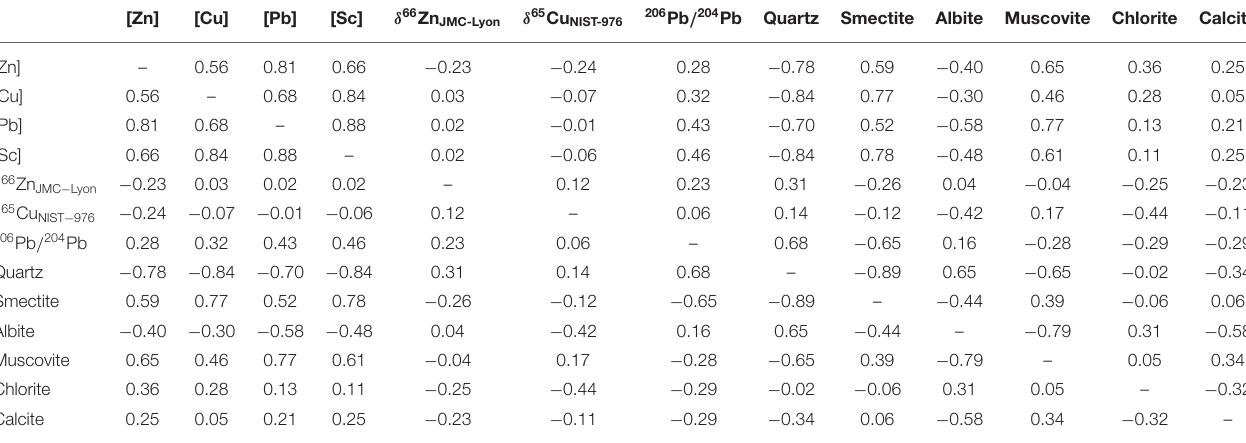
Values represent the Pearson product-moment correlation coefficient,